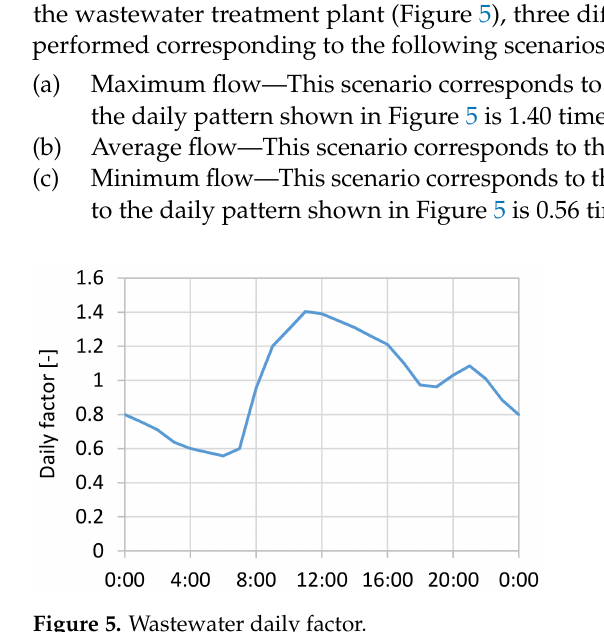
Figure 5. Wastewater daily